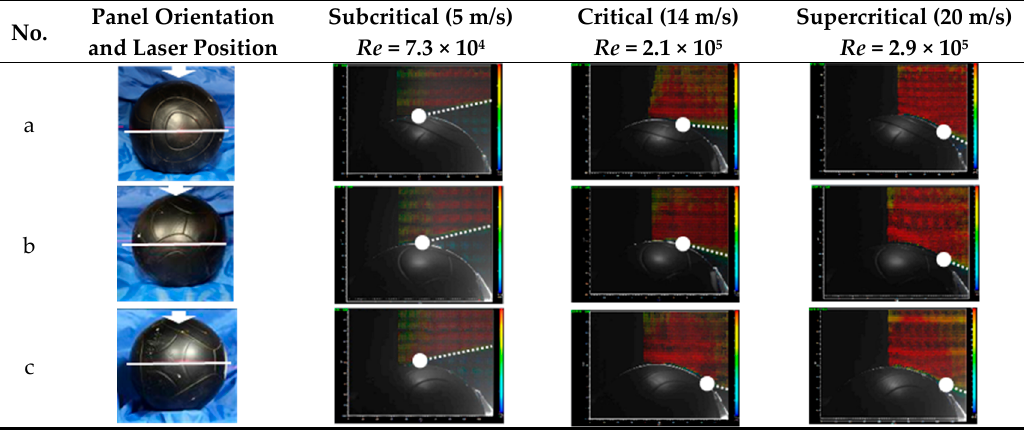
Table 4. The PIV results of the Jabulani with different panel orientations and different flow aspects.